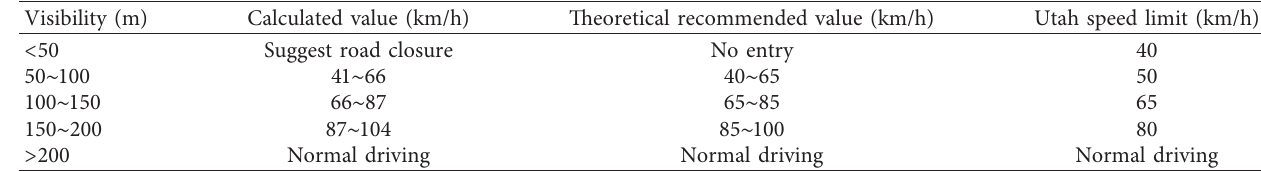
Table 1: Low-visibility speed limit.